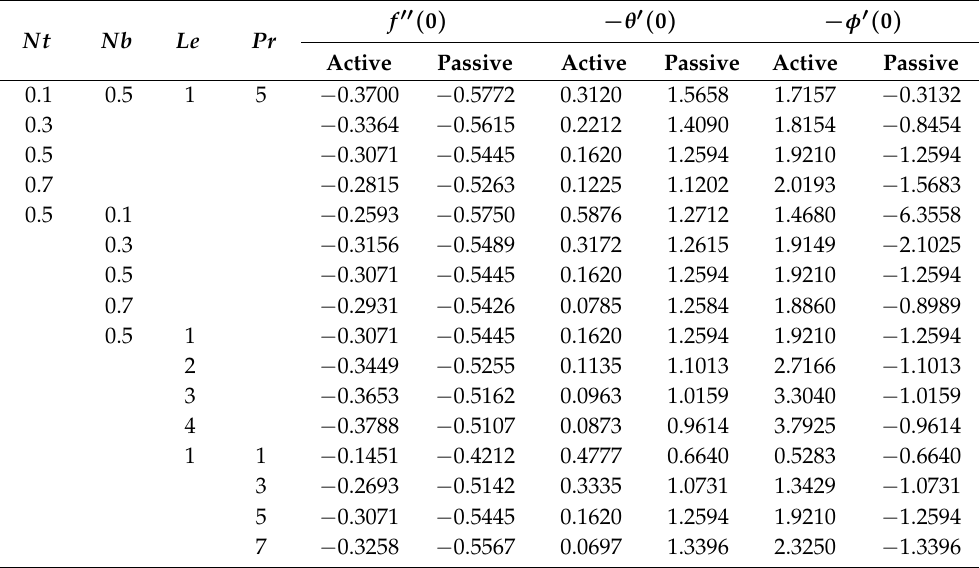
Table 3. Values of f (cid:48)(cid:48) ( 0 ) , − θ (cid:48) ( 0 ) , and − φ (cid:48) ( 0 ) for parameters Nt , Nb , Le , and Pr under active and passive